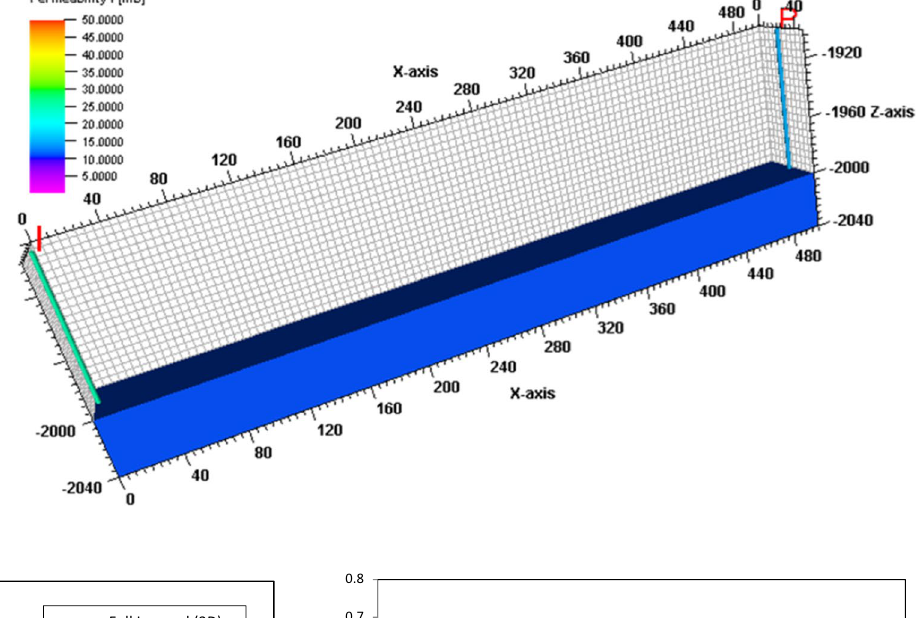
Fig. 5 Permeability distribution for 2D areal model